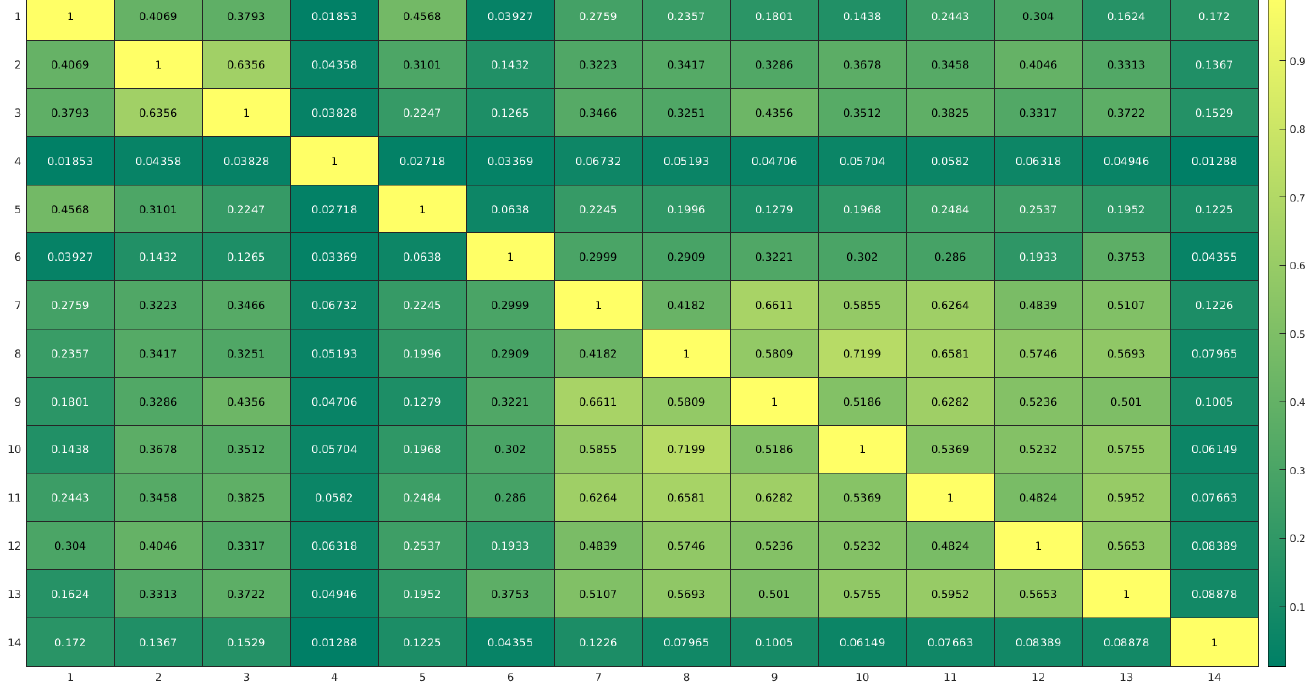
Figure 2. Correlation matrix showing the association between the answers to the questions numbered progressively in Table 2.